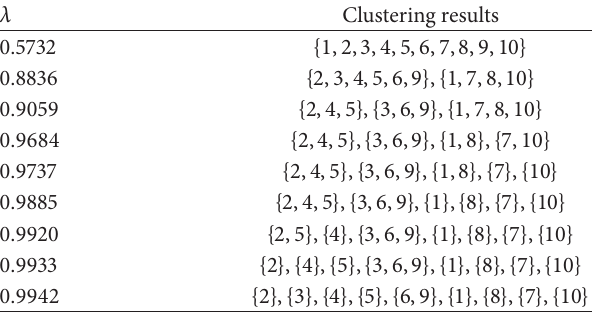
Table 8: Fuzzy nearness between field data and category center of Nanping Bridge.